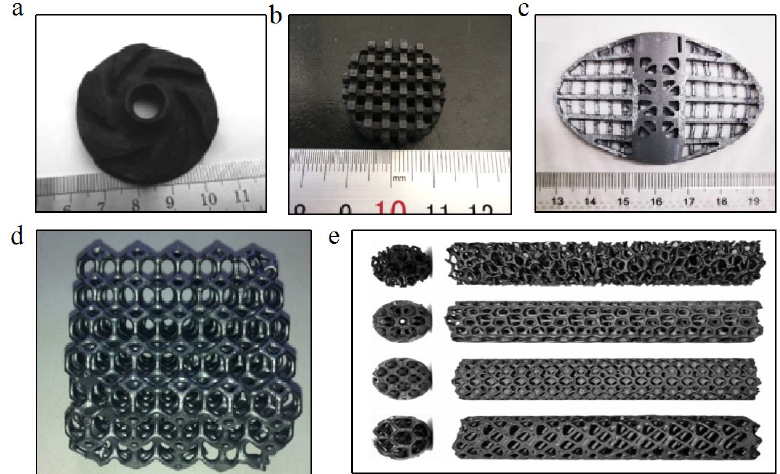
Fig. 5 Indirect additive manufacturing of SiC ceramic: (a) SL prepared polymer template, gel casting, and pressureless sintering. Reproduced with permission from Ref. [34], © Elsevier Ltd and Techna Group S.r.l. 2017. (b) FDM prepared polymer template, gel casting, and pressureless sintering. Reproduced with permission from Ref. [35], © Elsevier Ltd and Techna Group S.r.l. 2017. (c) Indirect additive manufacturing of lightweight C sf /SiC ceramic matrix composite mirror: SL prepared short carbon fiber template, and LSI. Reproduced with permission from Ref. [36], © Elsevier B.V. 2020. (d, e) SL prepared polymer template, slurry infiltration, and LSI or PIP. Reproduced with permission from Ref. [39], © Elsevier B.V. 2012, and Ref. [40], © ASME